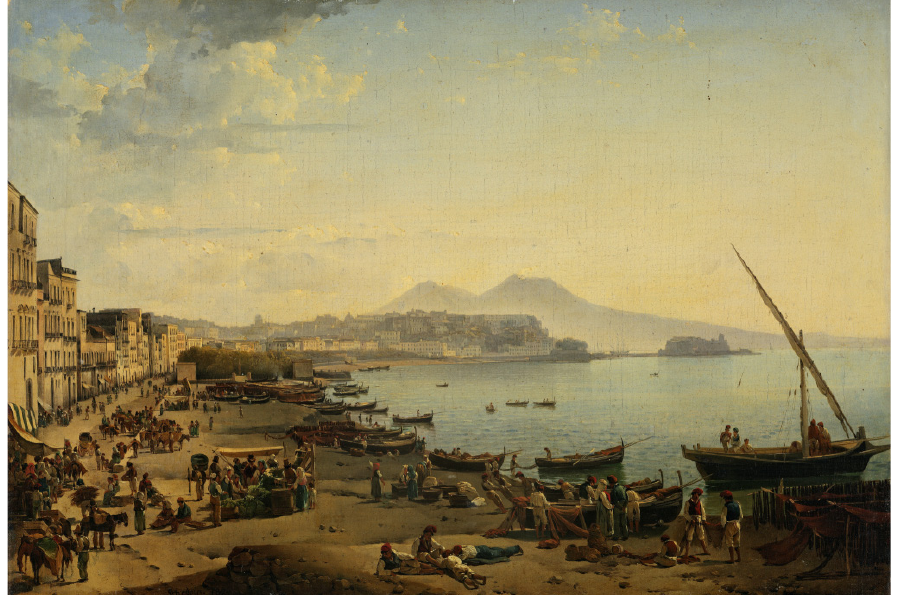
Figure 25. Sylvester Shchedrin. A View of Naples. On the Embankment (Riviera di Chiaia) , 1826. State Tretyakov Gallery, Moscow.